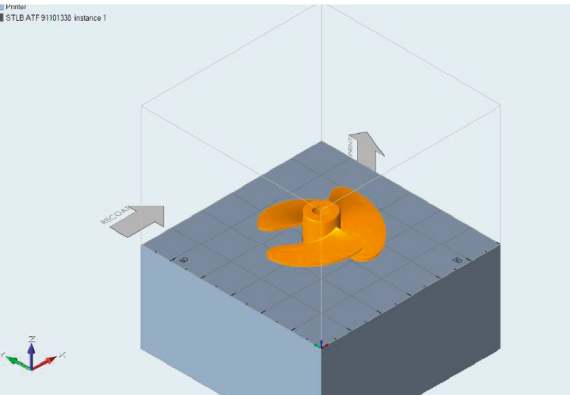
Figure 3: Showing the position of the part which is going to be developed over the metal powder bed and we can see the Direction of Print and Recoat